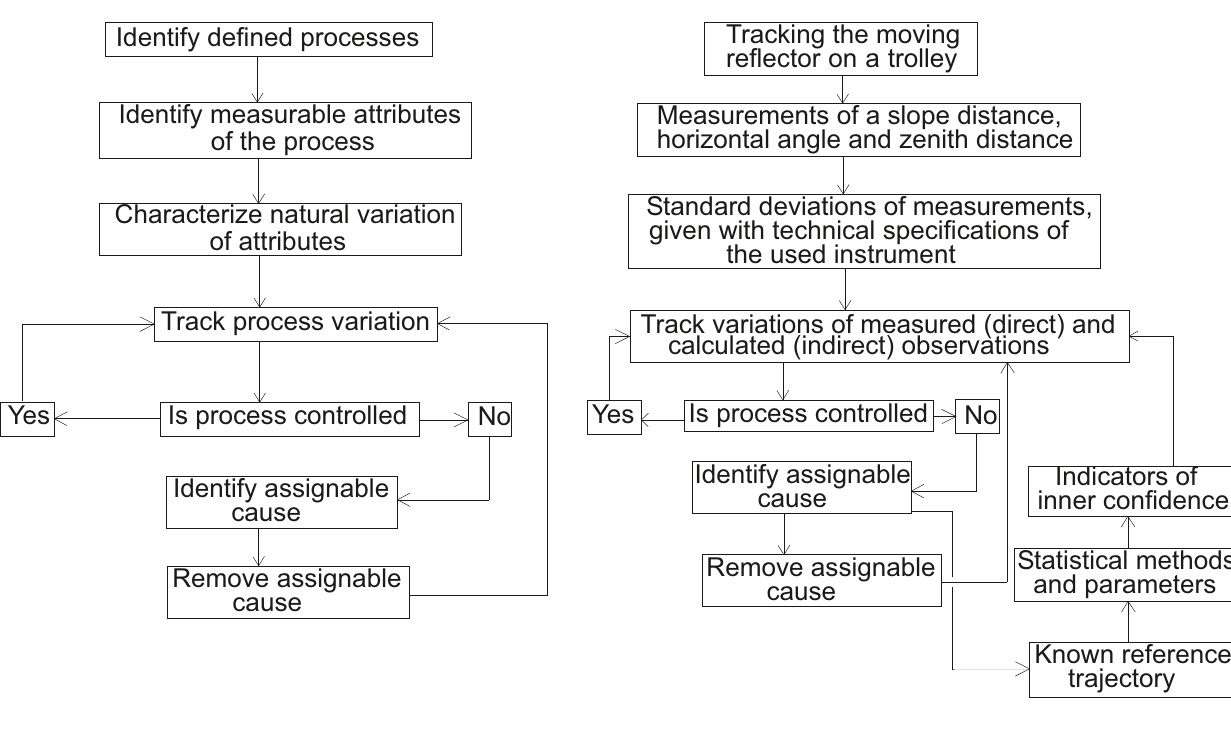
Figure 2. ( Left ) Statistical process control [11]. [2014] CSIAC. Reprinted, with